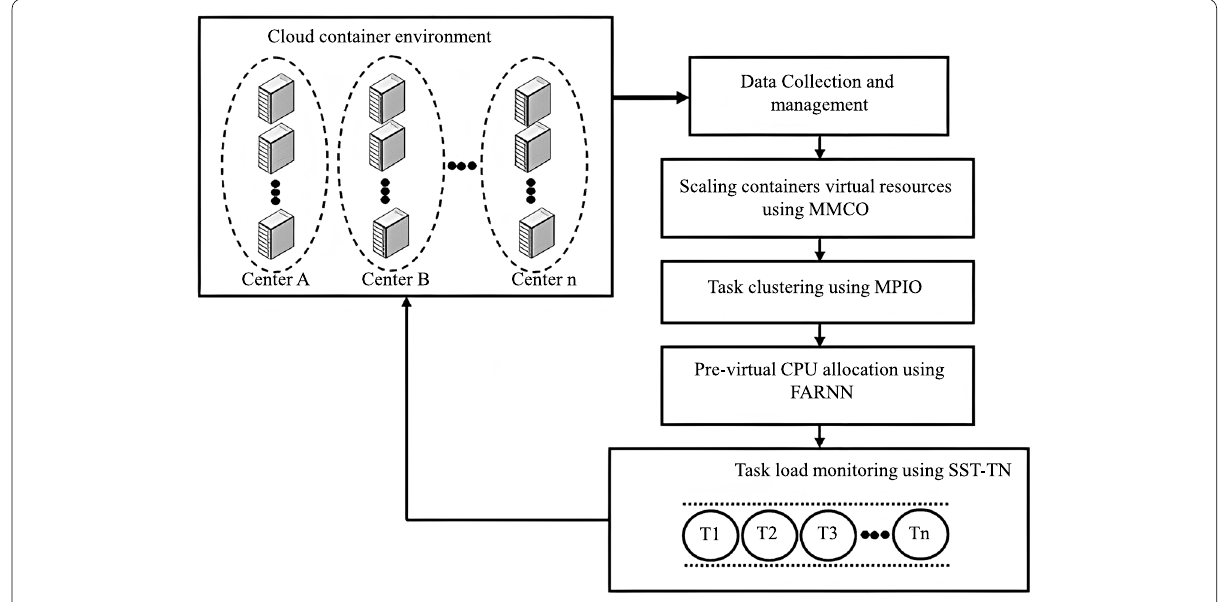
Fig. 1 Dynamic scalable task scheduling (DSTS)